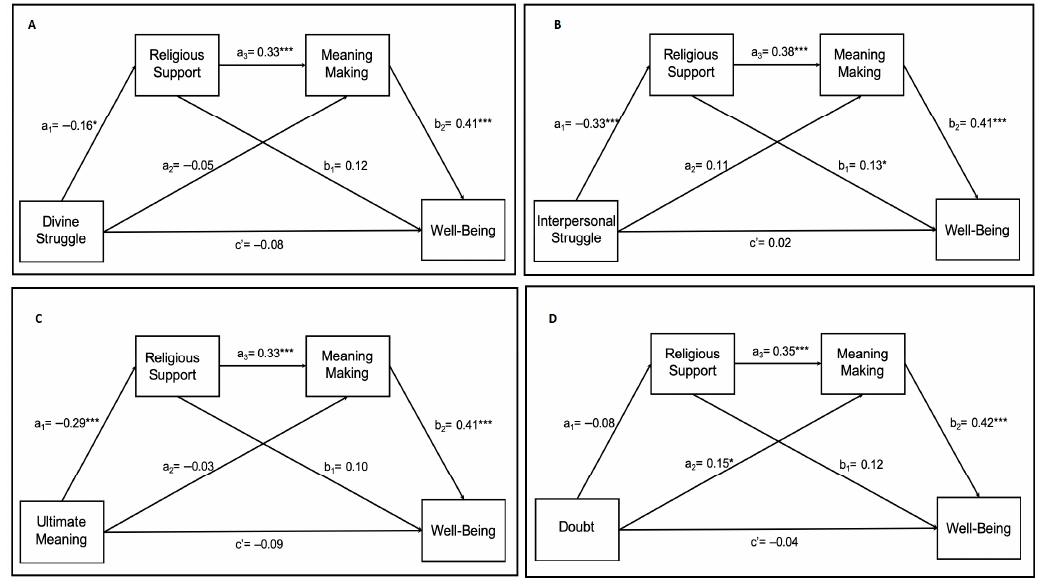
Figure 2. Standardized regression coefficients for the relationships between divine ( A ), interpersonal ( B ), ultimate meaning ( C ), and doubt ( D ) struggles and Well-Being as mediated by God, congregation, and clergy support. Significance level: *** p < 0.001; * p < 0.05.